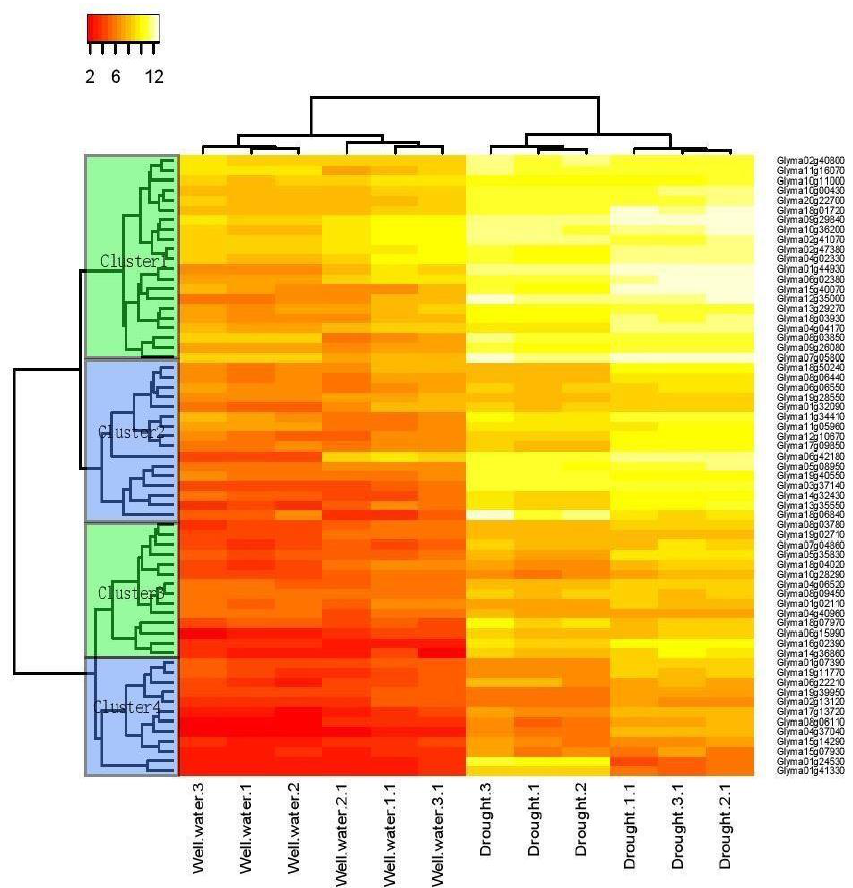
Figure 1. Heat map showing genes upregulated during drought. A total of 63 genes (Table S1) upregulated during drought stress and four clusters were obtained by using expression spectrum. In order to obtain optimal drought-responsive genes, the intersection of genes upregulated in both studies (ZT0, Z4 [41]; and R2, V6 [42]) was finally used as the final candidate drought corresponding genes. By processing the chip data in the literature [42] to obtain the drought-responsive gene expression profiles under di ff erent conditions, and then clustering the expression profiles to obtain four